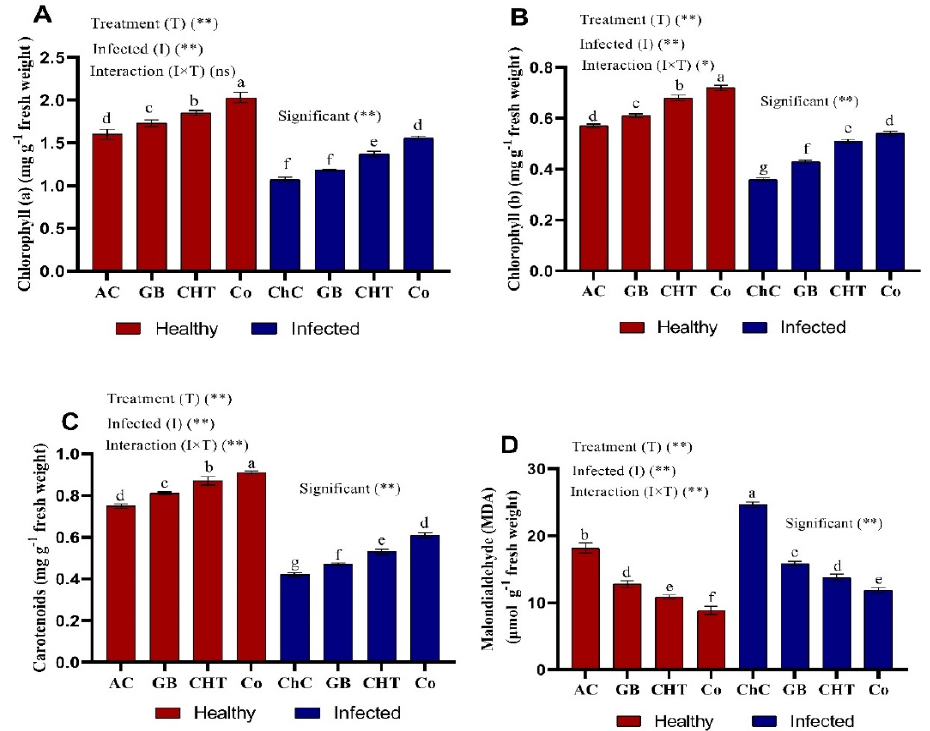
Figure 3. Effect of foliar spray by glycine betaine (GB), chitosan (CHT) and combination (Co) on photosynthetic pigments ( A , B , C ) and malondialdehyde (MDA) ( D ) content in leaves of cucumber plant under absolute control (AC) and CMV infection (challenge control, ChC) after 21 days of inoculation. Means with the different letters (a, b, c, d, e, f, g) are significantly different at the 0.05 level among treatments according to Tukey’s test. Vertical bars represent means of three independent determinations ± standard error (SE). *, ** and ns indicate significant, highly significant and ns, statistically insignificant difference according to two-way ANOVA with Tukey’s post hoc test.